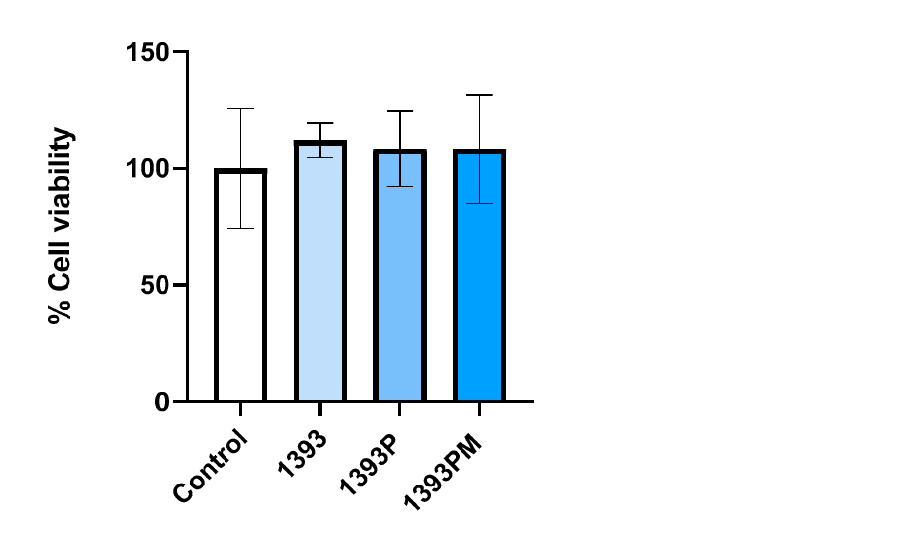
Figure 13. Evaluation of direct contact cytotoxicity of materials based on MTT analysis. The % cell viability corresponds to the ratio of OD (570–630) for each material condition normalized to control (hAMSCs cultured onto plastic) after 24 h of cell culture. Three replicates per condition, ANOVA test, p * < 0.05.